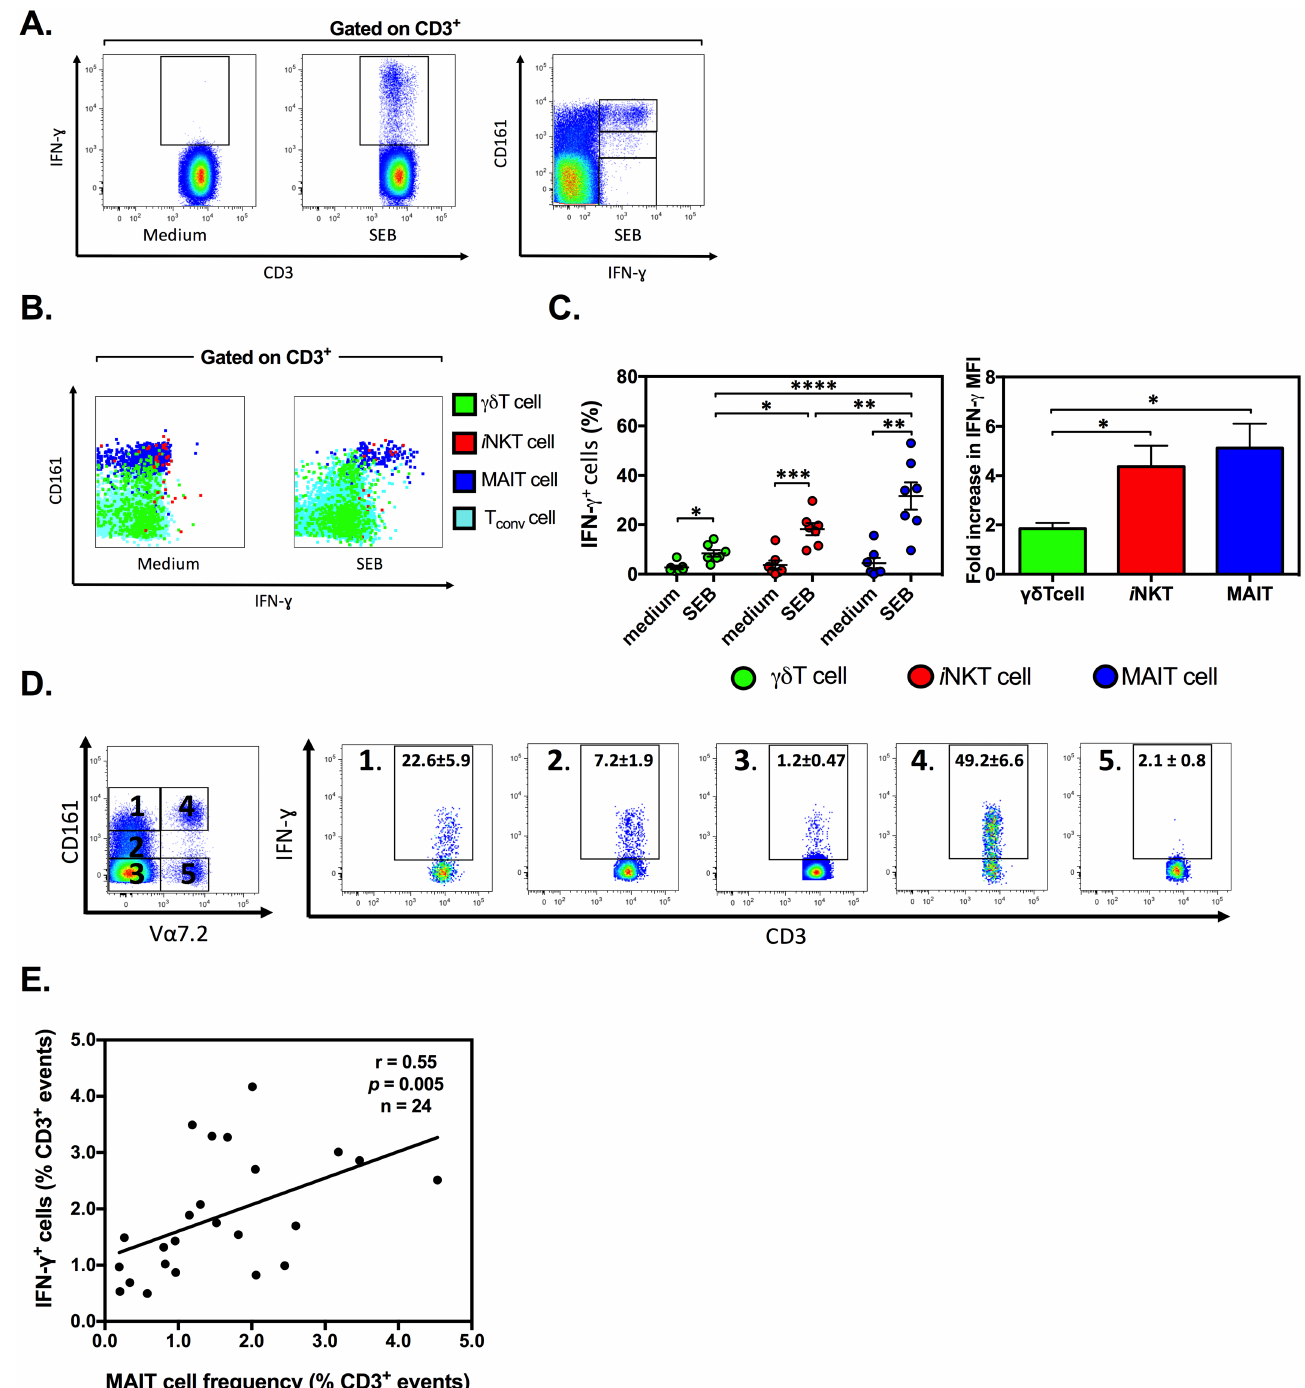
Fig 1. Human peripheral blood mucosa-associated invariant T (MAIT) cells are a predominant source of interferon (IFN)- γ after exposure to staphylococcal enterotoxin B (SEB). Human peripheral blood mononuclear cells (PBMCs) were left untreatedor stimulatedfor 24 h with 100 ng/mL of SEB. IntracellularIFN- γ was detected by flow cytometry among bulk CD3 + , CD3 + CD161 - , CD3 + CD161 low , and CD3 + CD161 high cells ( A ). PBMCs were additionallystainedwith monoclonal antibodies(mAbs) to T cell receptor(TCR) γδ and TCR V α 7.2 and with PBS-57-loaded CD1d tetramer. Events corresponding to γδ T (green), invariant natural killer T ( i NKT) (red), MAIT (blue), and conventional T (T conv ) (cyan) cells were superimposed to generate a dot plot ( B ). The frequencyof IFN- γ + cells and the mean fluorescence intensity (MFI) of IFN- γ stainingwere determined in 7 donors, each of whom is representedby a circle ( C ). Five subpopulations were definedamongSEB-stimulated CD3 + cells basedon their co-expression of CD161 and